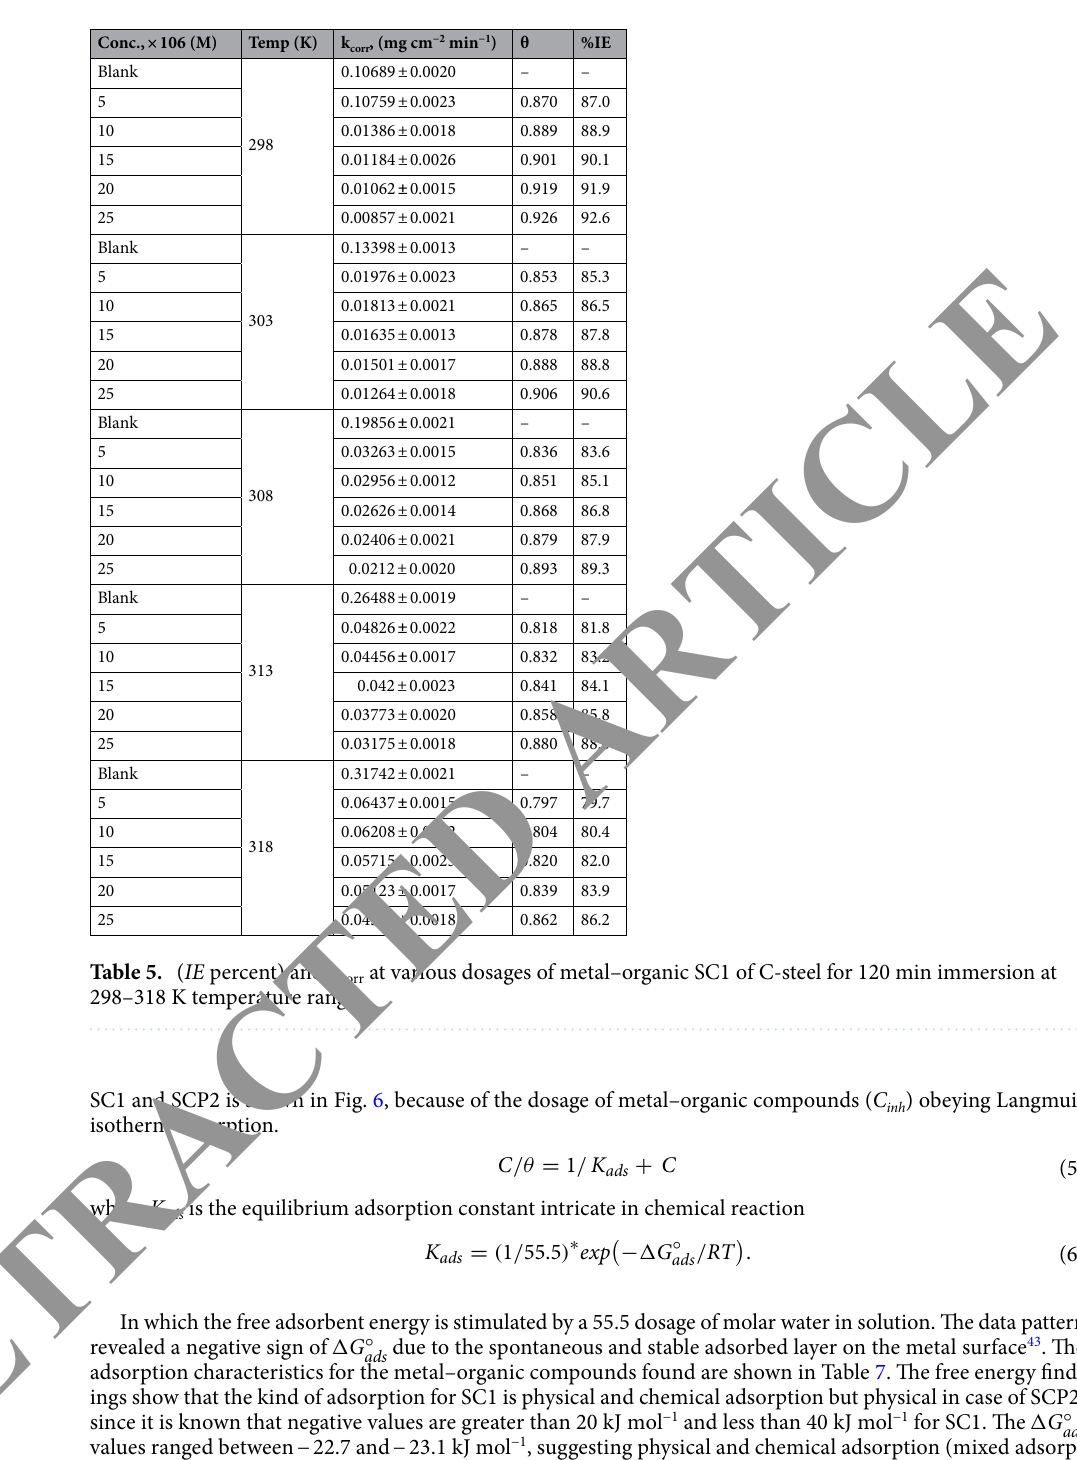
Table 5. ( IE percent) and k corr at various dosages of metal–organic SC1 of C-steel for 120 min immersion at 298–318 K temperature